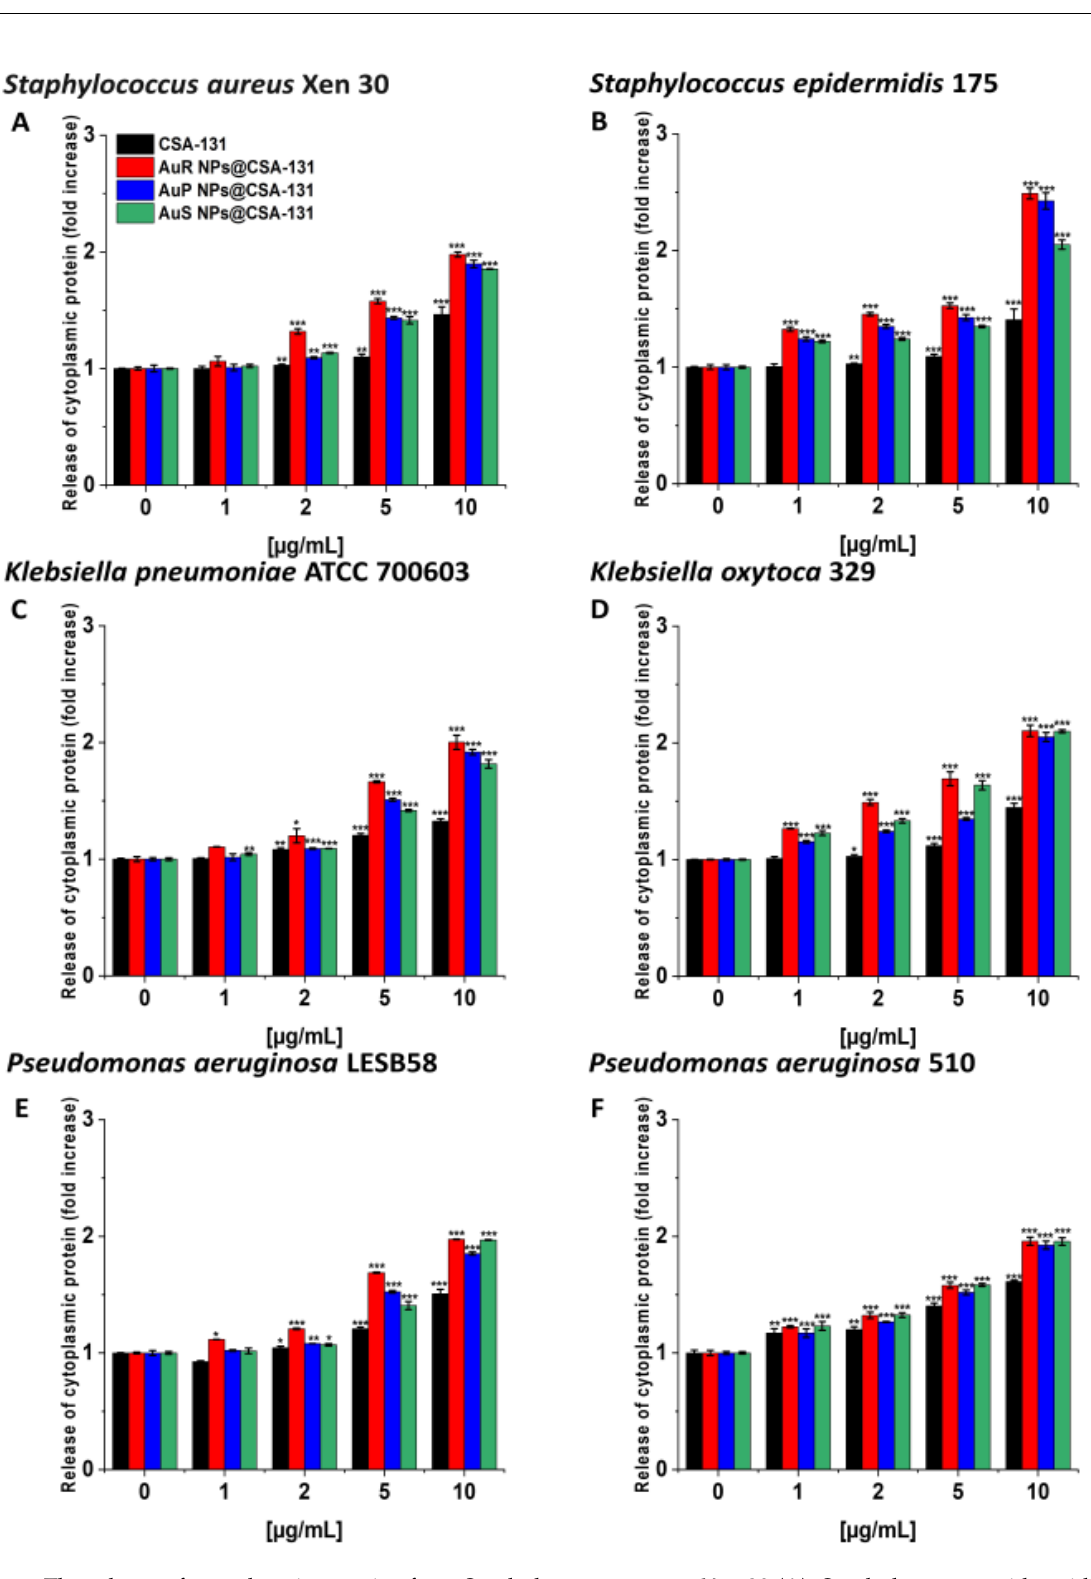
Figure 7. The release of cytoplasmic proteins from Staphylococcus aureus Xen 30 ( A ), Staphylococcus epidermidis 175 ( B ), Klebsiella pneumoniae ATCC 700603 ( C ), Klebsiella oxytoca 329 ( D ), Pseudomonas aeruginosa LESB58 ( E ), and Pseudomonas aeruginosa 510 ( F ) upon treatment with AuR NP@CSA-131, AuP NP@CSA-131, AuS NP@CSA-131, and CSA-131 at concentrations of 1–10 µg/mL was evaluated by Bradford protein assay. Results show the mean ± SD, n = 3; * indicates statistical significance at p ≤ 0.05, ** ≤ 0.01 and *** ≤ 0.001.